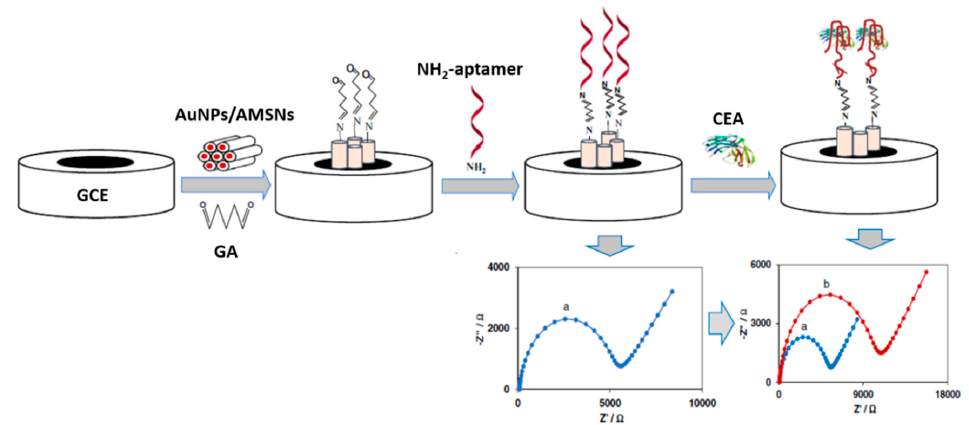
Figure 13. Impedimetric aptasensor for CEA using an AuNPs/AMSNs-GCE as transduction interface. Reprinted and adapted from [154] with permission.